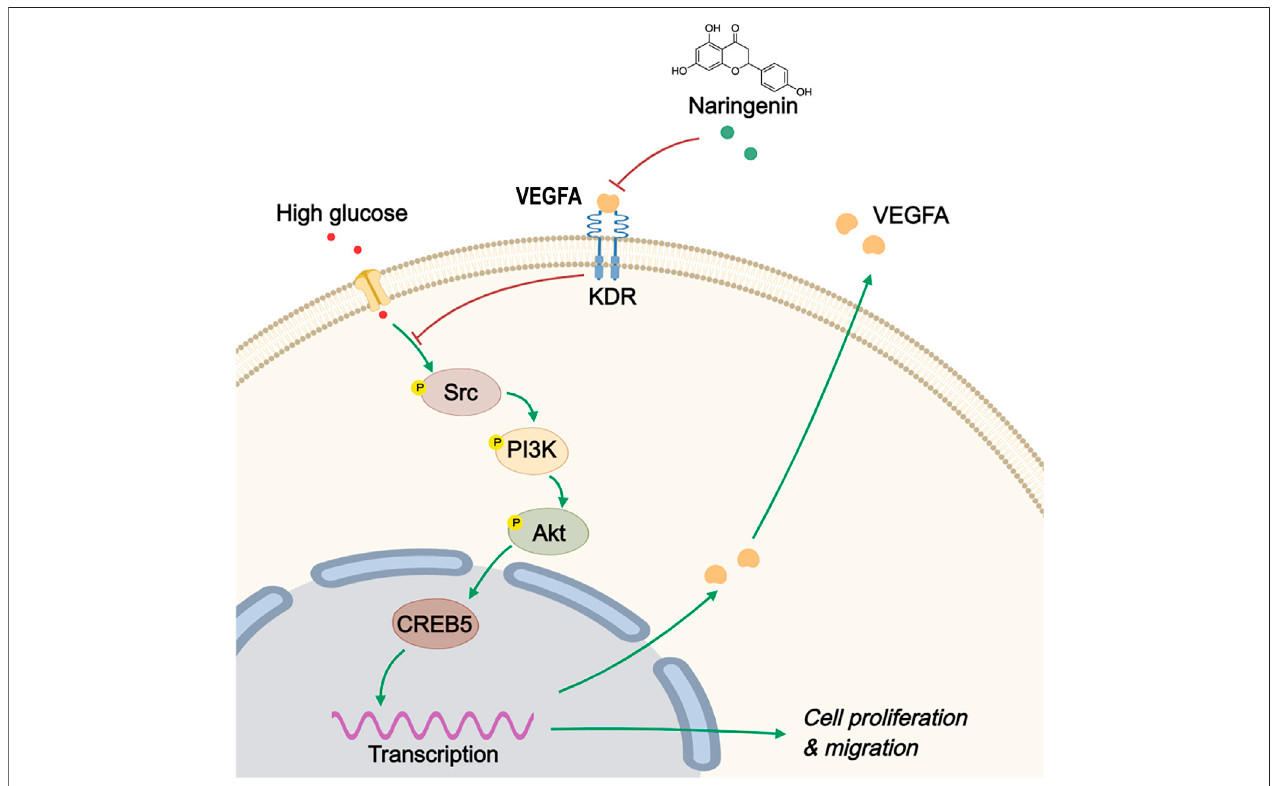
GRAPHICAL ABSTRCAT | Schematic diagram ofthe protective effect ofNar on high-glucose-induced VSMCsproliferation and migration via inhibiting PI3K/Akt/ CREB5 signaling pathway. High glucose could activate PI3K/Akt/CREB5 signaling pathway, leading to excessive proliferation and migration of VSMCs, but Nar could downregulated PI3K/Akt/CREB5 pathway through inhibiting the expression of VEGFA, which located on the upstream of PI3K/Akt signaling pathway, and inhibiting the expressionofp-PI3K,p-AktandCREB5atthesametime,whichdemonstratedthatNarhasananti-proliferationandanti-migrationeffectonhigh-glucose-induced VSMCs through inhibiting PI3K/Akt/CREB5 signaling